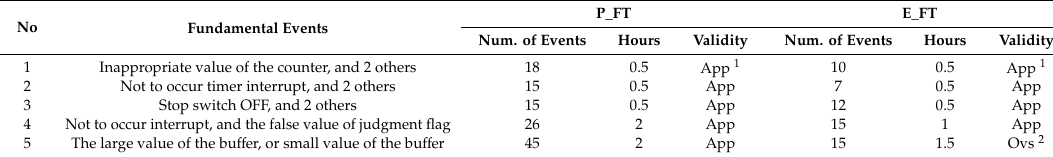
Table 3. Summary of the FT